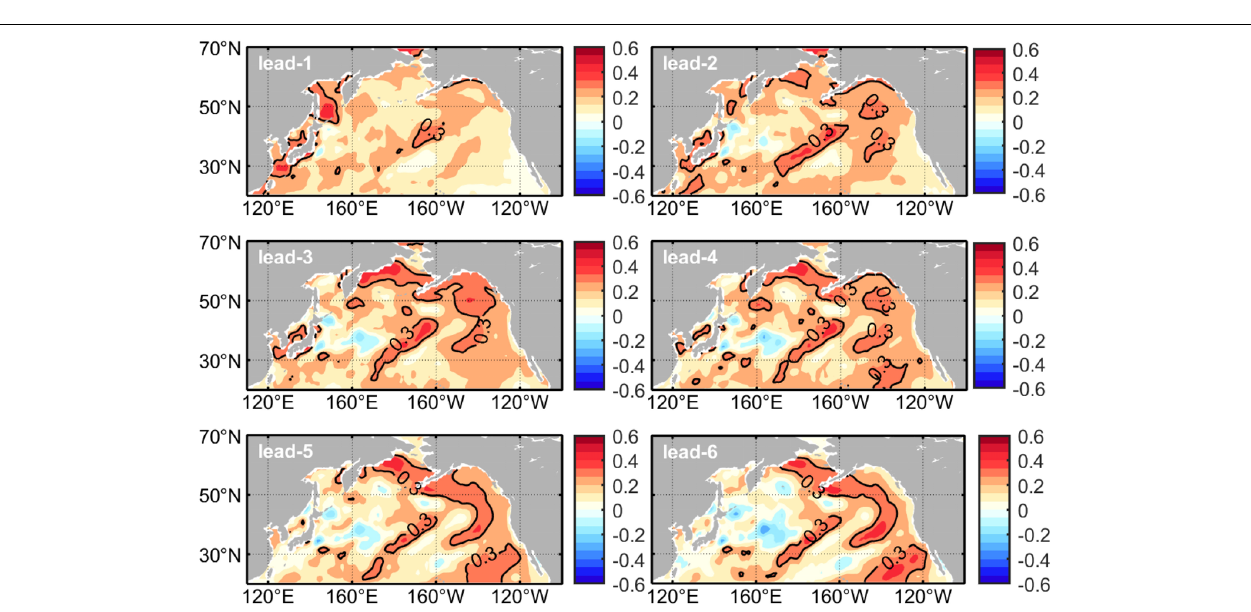
FIGURE 4 | Distributions of ACC between IOSST v2 and hindcasts using the EAKF and Projection-OI data assimilation methods for the 2-, 4-, 6-months lead in the North Pacific. Only the line of the 0.5 contour is plotted.